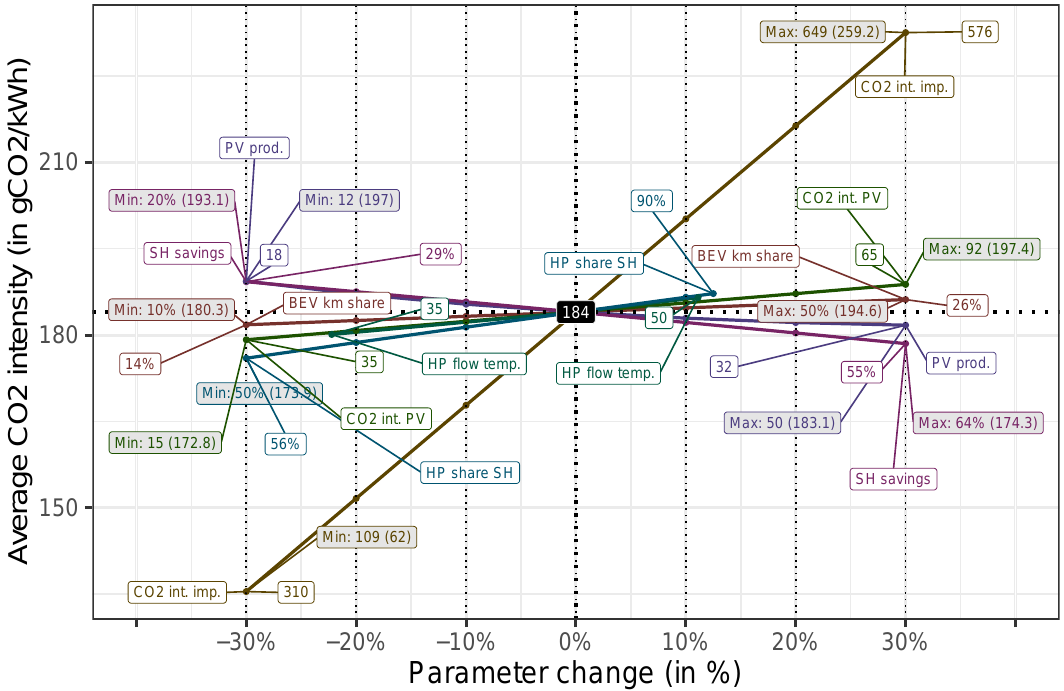
Figure 26. Sensitivity plot of the average CO 2 intensity with respect to plausible percentage changes of the key parameters in Table